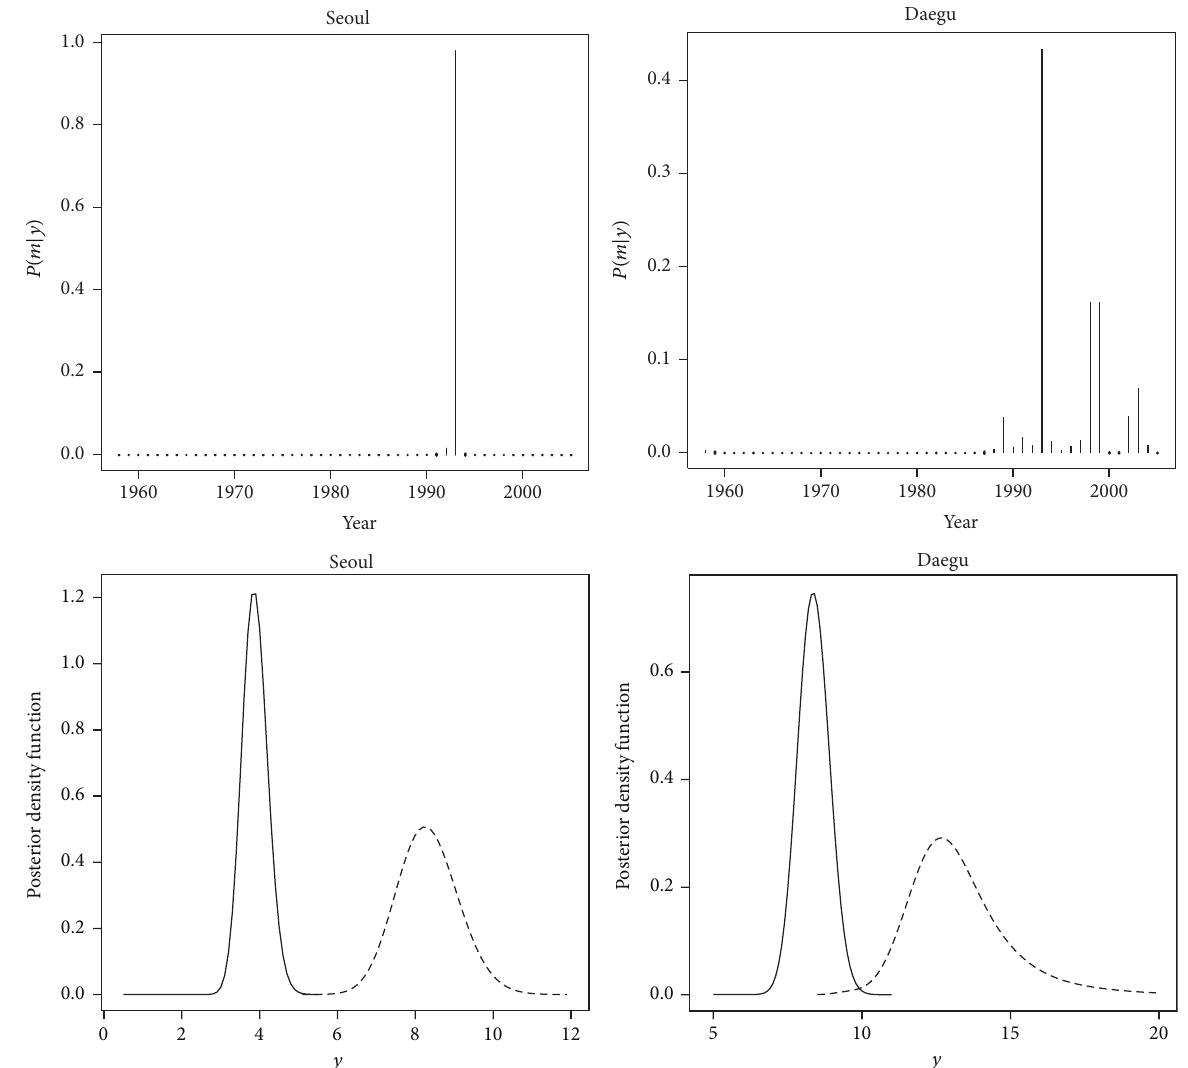
Figure 6: Posterior probability for the change-point, 𝑃(𝑚 | 𝑦) , and the marginal posterior density functions for 𝜆 and 𝜙 before and after the change-point after omitting the year